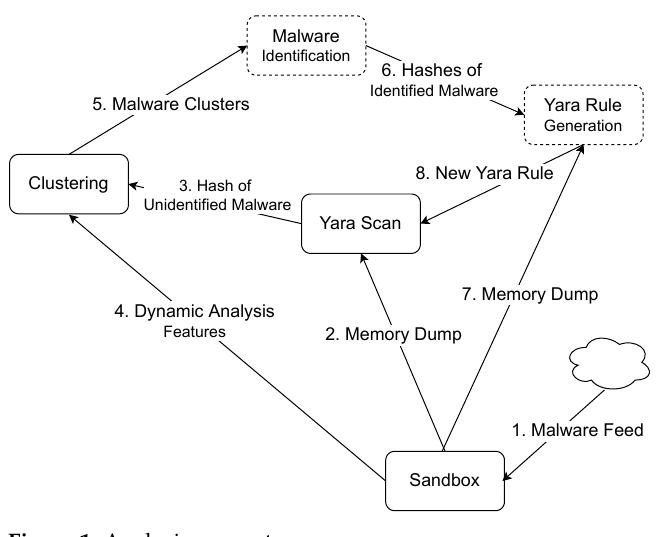
Figure 1. Analysis